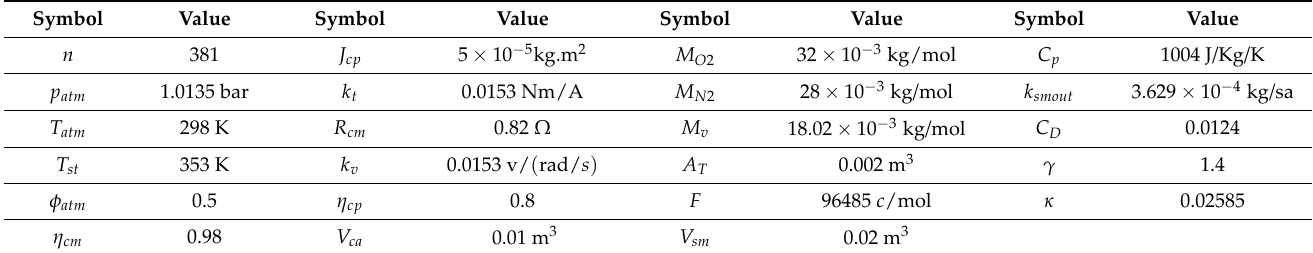
Table A2. The main physical parameters of